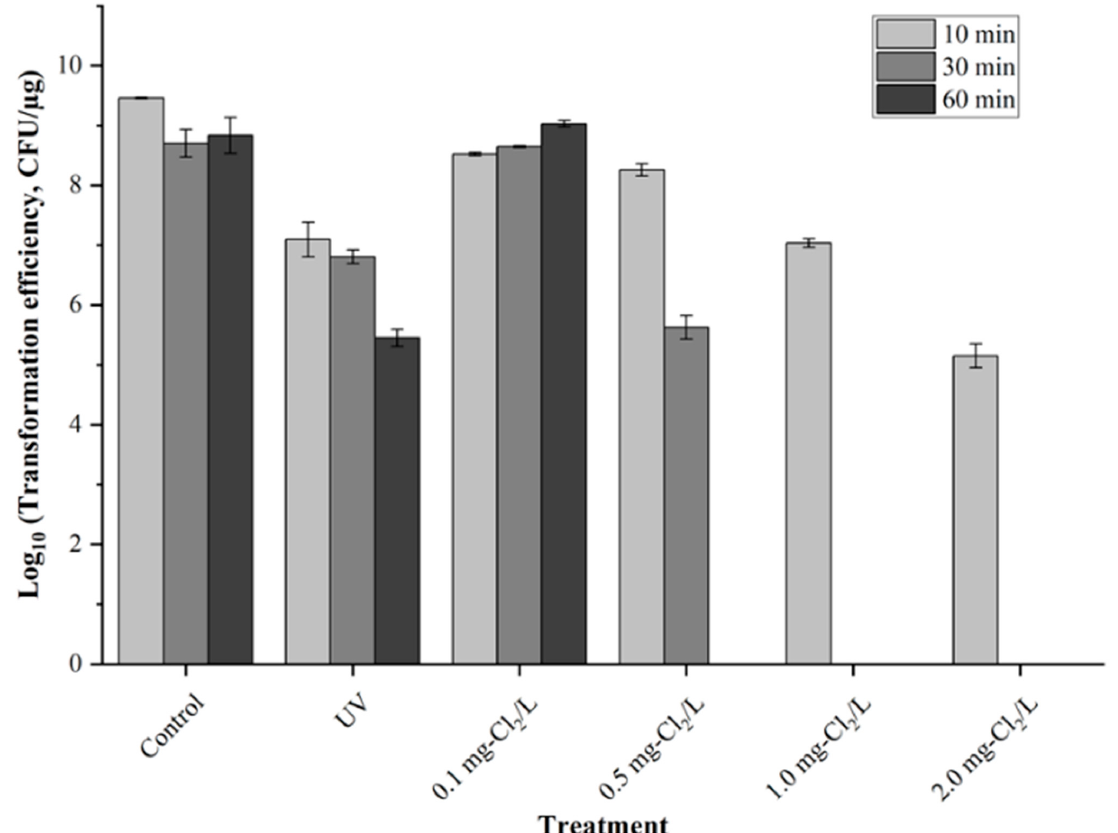
Figure 1. Transformation efficiency in E. coli after treatment with chlorine or UV light.